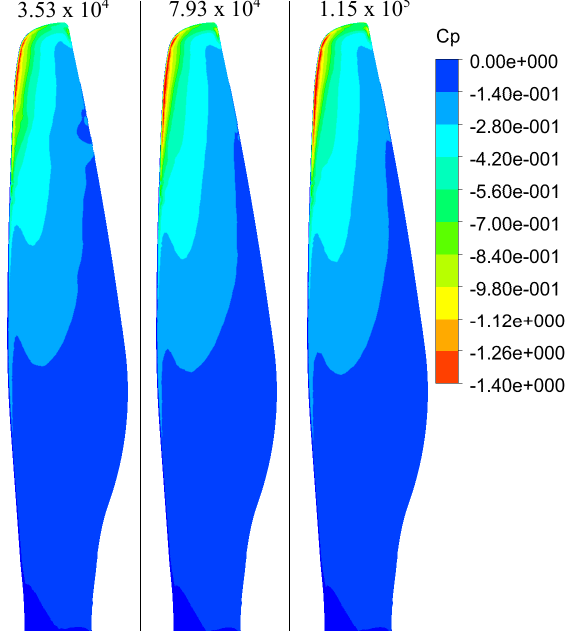
Figure 8. Pressure coefficient distribution on the upper surface of the rotor using the fully turbu- lent model.